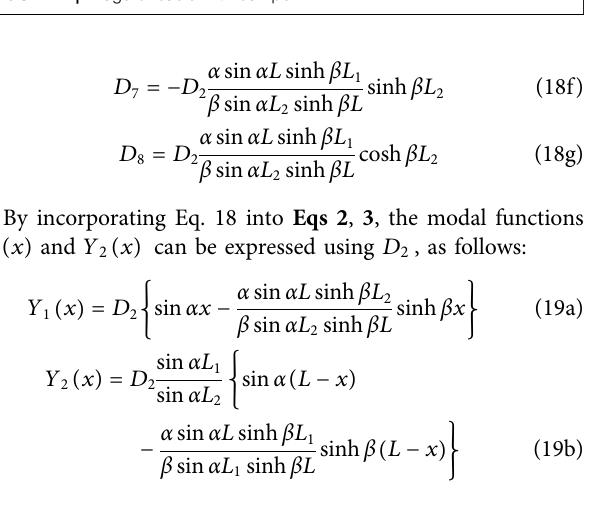
FIGURE 2 | Image of cable with